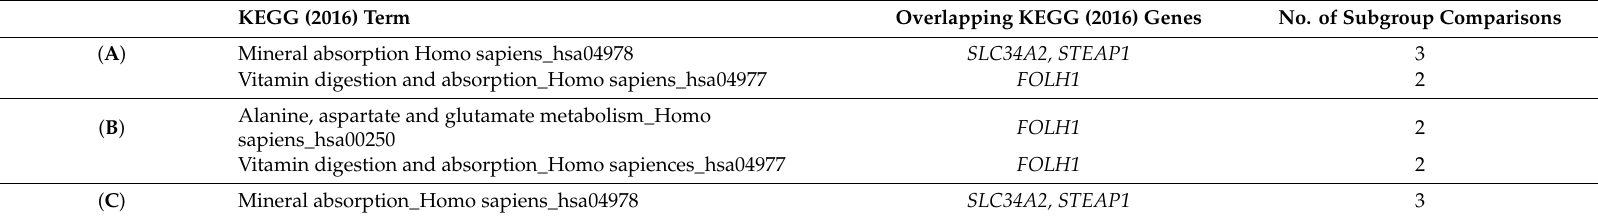
Table 3. Pathway analysis using the most common KEGG terms overall between both TARGET and TCGA data when examining the ( A ) total, ( B ) downregulated (log2 FC < 0), and ( C ) upregulated (log2 FC > 0) significantly di ff erentially expressed GOI identified from subgroup comparisons (with > 10 patients per subgroup) during DGE